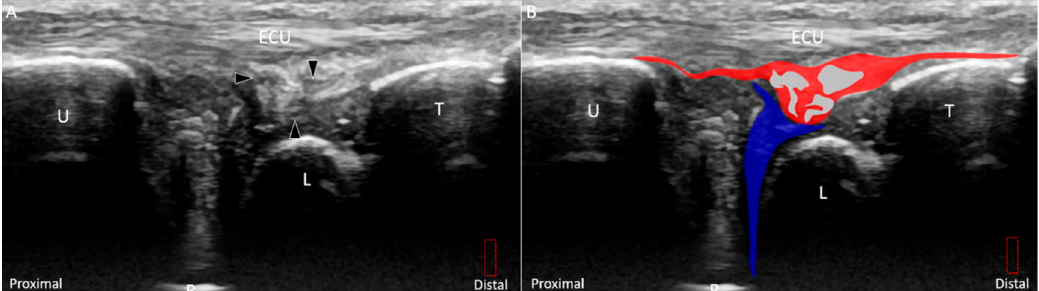
Figure 12. ( A ) US and ( B ) superposed US images using the long-axis approach show tears (black arrowhead and grey shade) of the meniscus homologue (red shade) and prestyloid recess effusion (blue shade) , indicating Class 1E triangular fibrocartilage complex injury. The different color dashed rectangles are in accordance with the transducer positions in Figure 3. US: ultrasound; U: ulna; R: radius; L: lunate; T: triquetrum; ECU, extensor carpi ulnaris.